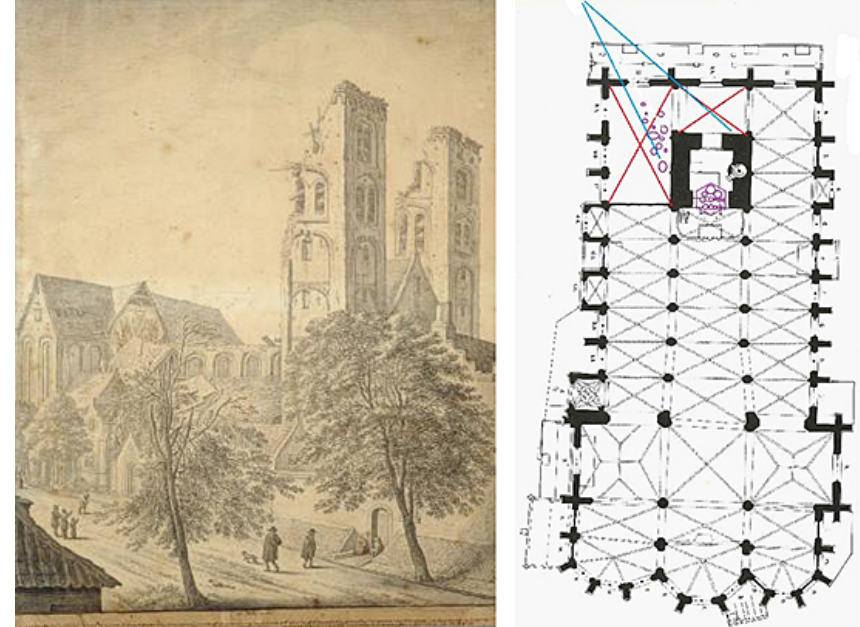
Figure 5. Left panel: drawing of the ruin of the Pieterskerk with the spires and part of the church towers removed by the storm. The direction of the fall is into the church. Drawing by Herman Saftleven (Utrecht City Archive no. 28644). Right panel: plan of the Jacobikerk, showing in blue the reconstruction of the direction in which the spire fell in the 1674 storm. In purple, the carillon is shown in its separate spire east of the main spire, with the position of the bells on the church floor after the collapse of the spire. In red, the destroyed arches are shown (which have never been repaired). Figure from Kipp